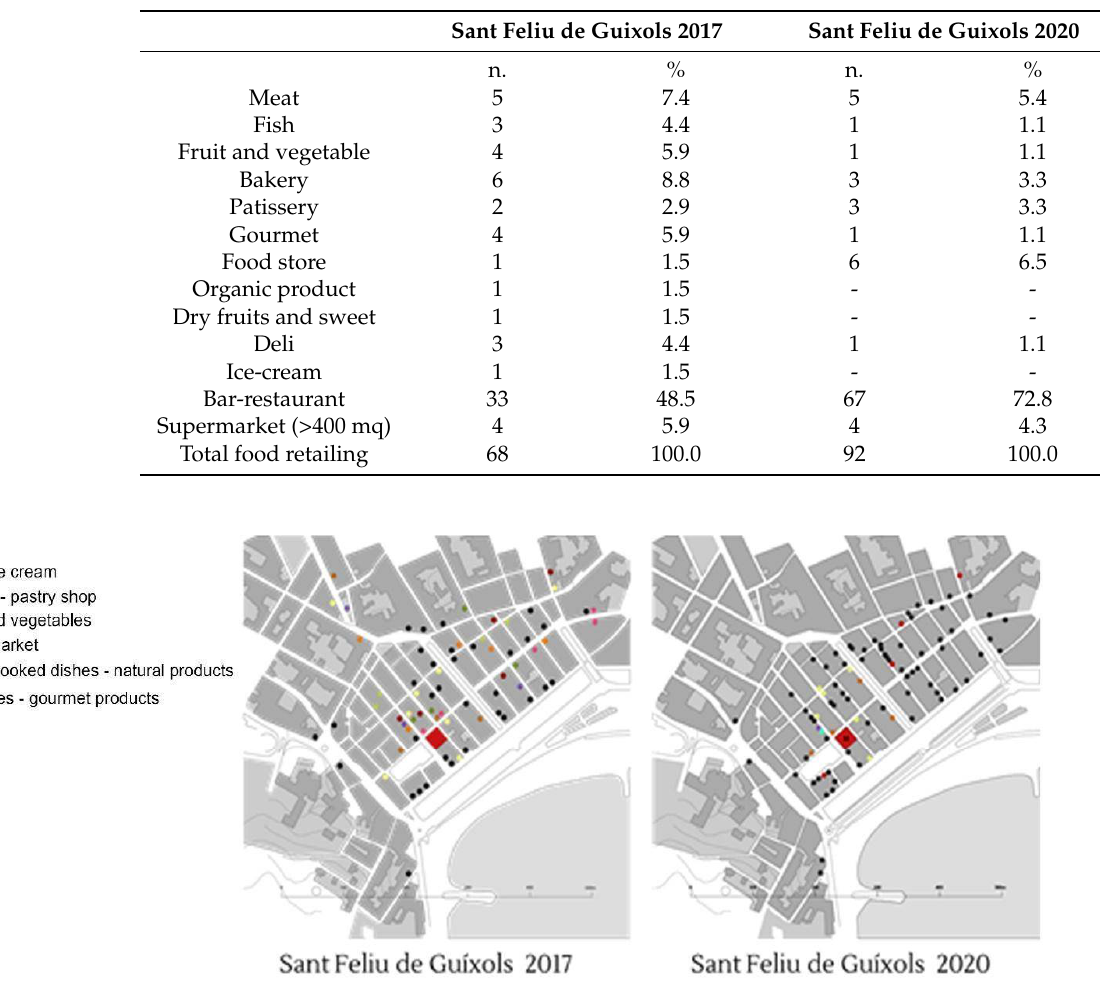
Figure 2. Food retailing historical analysis (2017 and 2020). Left: Food vs. restaurant businesses. The area with the greatest concentration coincides with the market location. In 2017, 45% of food shops were restaurants and bars. In 2020, they represented 73%. Source: Maximiliano Monsalvo González, Joaquim Perea i León.